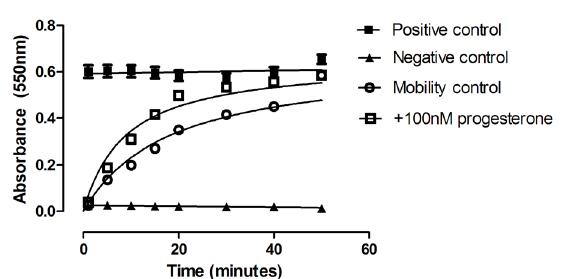
Figure 1. Progesterone accelerates the mobility of non-capacitated boar sperm. Under control conditions sperm penetrate the Accudenz solution with a Km = 18.0 ± 2.2min (mobility control, 18 replicates). Sperm penetrate at a significantly (P=0.01) enhanced rate through the Accudenz solution containing 100nM progesterone (+100nM progesterone; Km = 8.8 ± 0.8min, 20 replicates). Data sets are analysed as described in methods and results and are an average of 4 ejaculates from different boars with pooled replicates as indicated. Positive and negative control data sets are an average of 4 ejaculates measured in